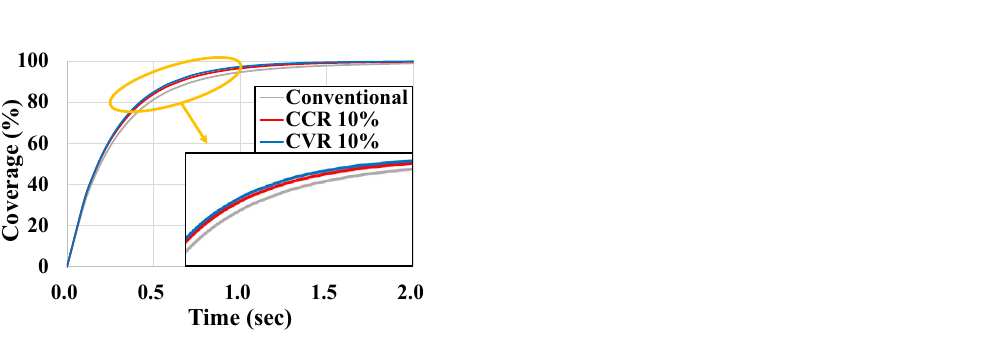
Figure 12. Coverage according to model